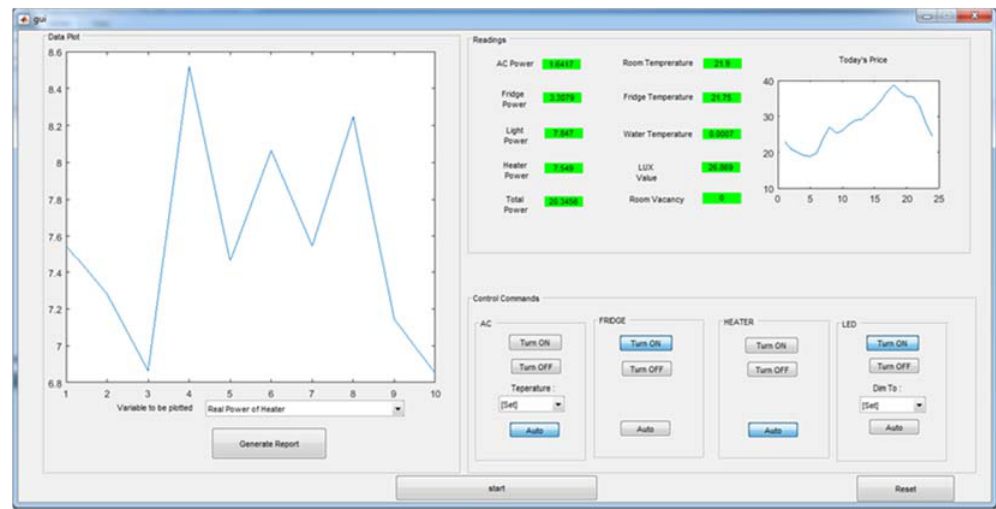
Figure 2. Graphical user interface of the proposed energy management system.